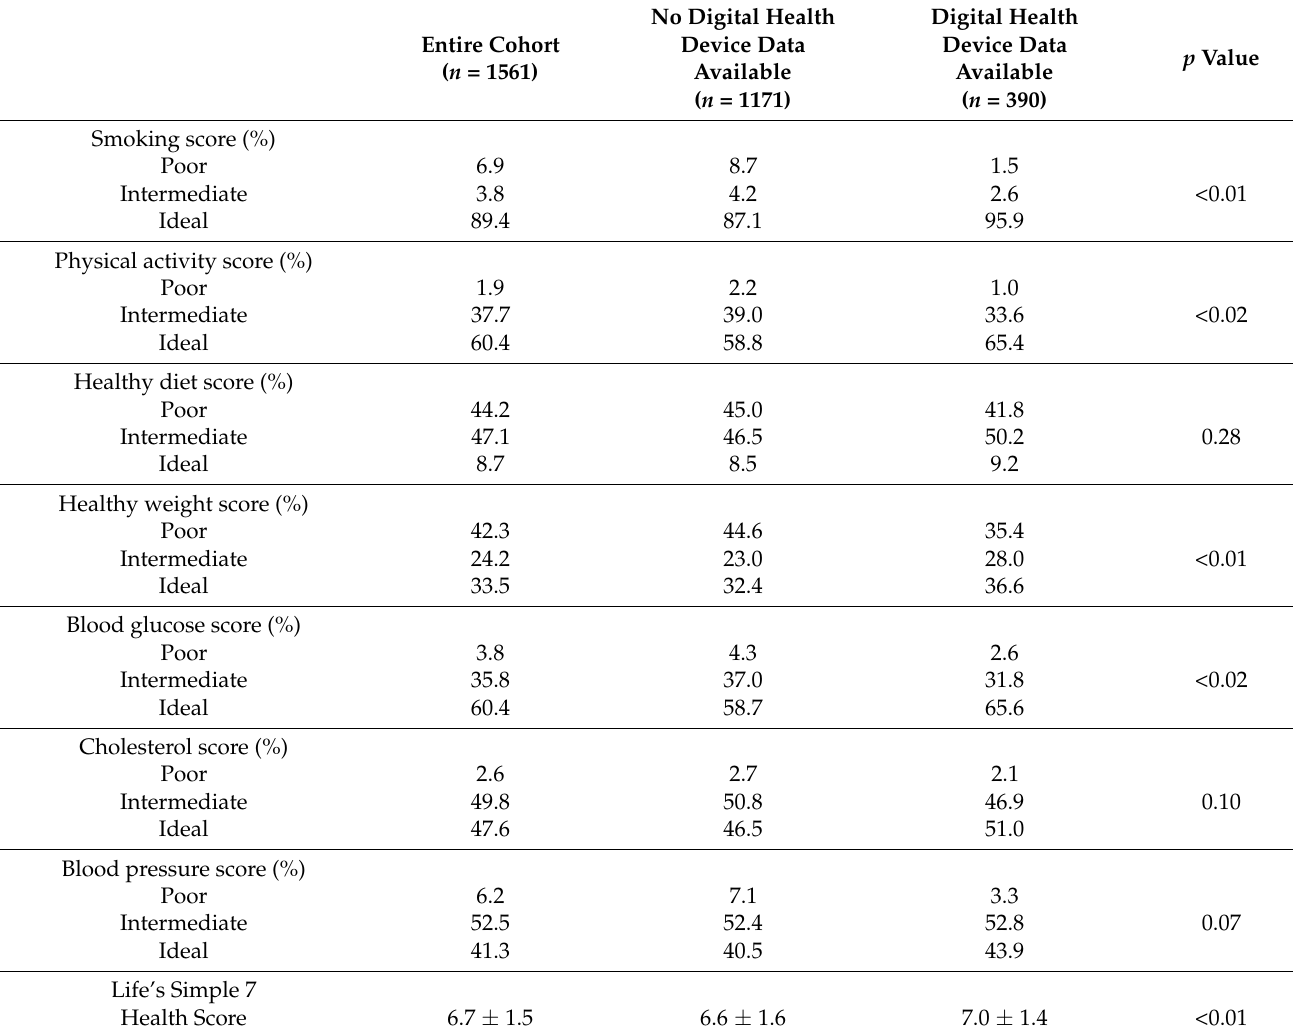
Table 3. Life’s Simple 7 Health Score calculated from participant self-reported